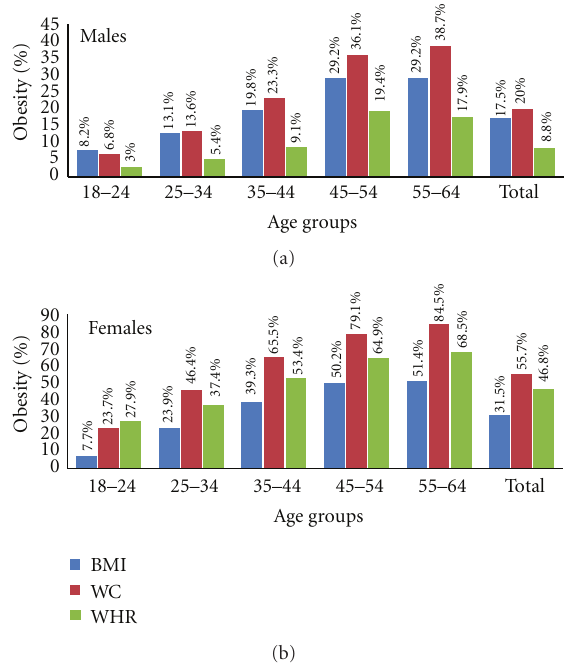
Figure 1: Prevalence of obesity as yielded by BMI, WC, and WHR, in Palestinian adults by gender: findings of the first national health and nutrition survey (FNHANS) 1999-2000. BMI (body mass index ≥ 30kg/m2), WC (waist circumference ≥ 102cm in men and ≥ 88 cm in women), and WHR (waist-to-hip ratio ≥ 1 in men and ≥ 0.85 in